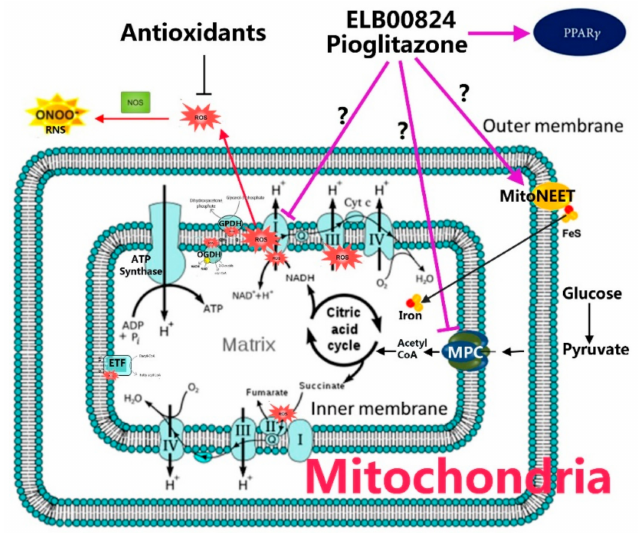
Figure 6. Major mitochondrial sites of reactive oxygen species (ROS) production as potential targets of ELB00824 and antioxidants. The red stars are major ROS production sites. It is hypothesized that ELB00824 targets mitochondrial proteins, such as complex I of the mitochondrial respiratory chain, mitoNEET, or MPC (mitochondrial pyruvate carrier), and leads to a reduction in ROS generation, while antioxidants target ROS